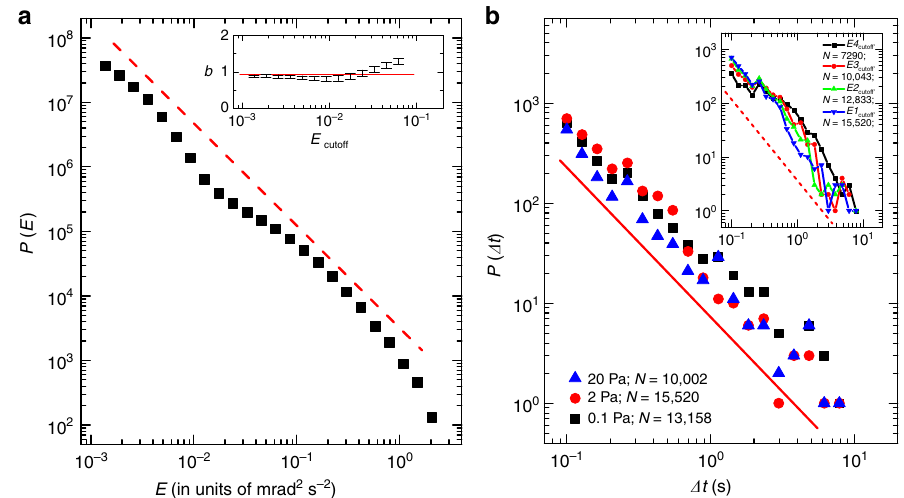
Fig. 2 Statistics of kinetic energy of quakes (Gutenberg – Richter law) and inter-occurrence waiting time . a Probability density of the kinetic energy ( P ð E Þ ) versus kinetic energy ( E ) of quakes for d = 10 μ m and σ ¼ 2 Pa data (plotted in Fig. 1b) is shown. The red dashed line is drawn parallel to the linear fi t with slope ϵ ¼ 1 : 6 ± 0 : 1, indicating the Gutenberg – Richter exponent b ¼ 0 : 90 ± 0 : 15 (see the article for de fi nition). Inset shows b as a function of lower cutoff of energy E , obtained via the maximum likelihood (ML) method, that is, considering only quakes with E > E cutoff errors in b . The horizontal red line represents b ¼ 0 : 9 value. The results for other bursts are very similar (see Supplementary Fig. 6). b Distribution of waiting time ( Δ t , the time separation between successive quakes) for different σ having d ¼ 10 μ m considering quakes with E > 2 : 07 ´ 10 (cid:3) 2 in units of mrad 2 s (cid:3) 2 is shown. Inset shows similar plot for 2 Pa data with different energy thresholds ( E 1 E 3 ¼ 5 : 46 ´ 10 (cid:3) 2 , E 4 ¼ 8 : 86 ´ 10 (cid:3) 2 ). Both, the red solid line and the red dashed line in the inset, show power-law decay with exponent 1.5. N is cutoff cutoff the counted quakes of each